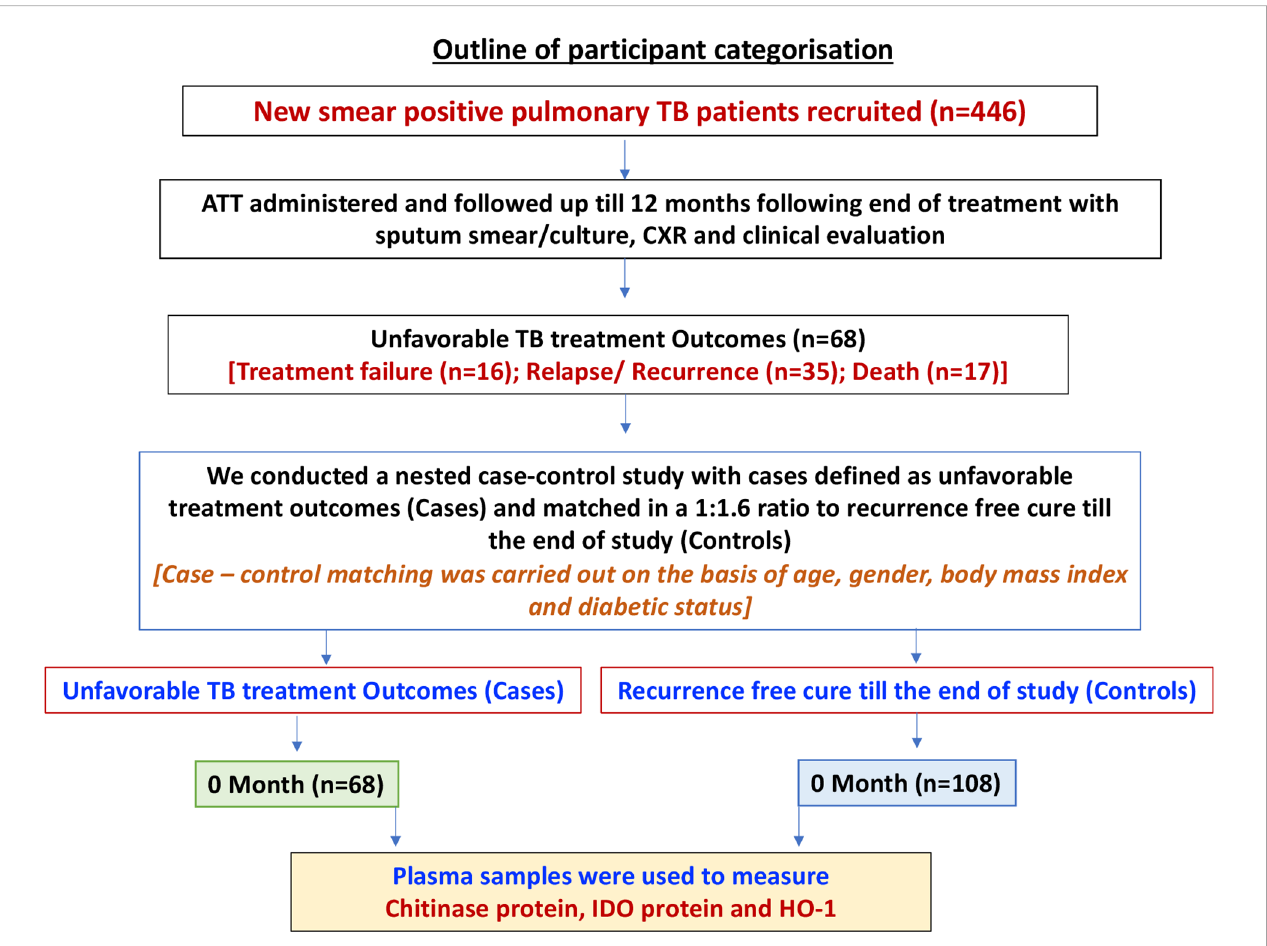
FIGURE 1 Outline of participant categorization. A schematic of our study cohort showing new smear positive pulmonary TB patients with poor treatment outcome [Cases (n=68)] and recurrence free cure till the end of study [Control (n=108)]. Plasma samples were isolated from whole blood of both the study